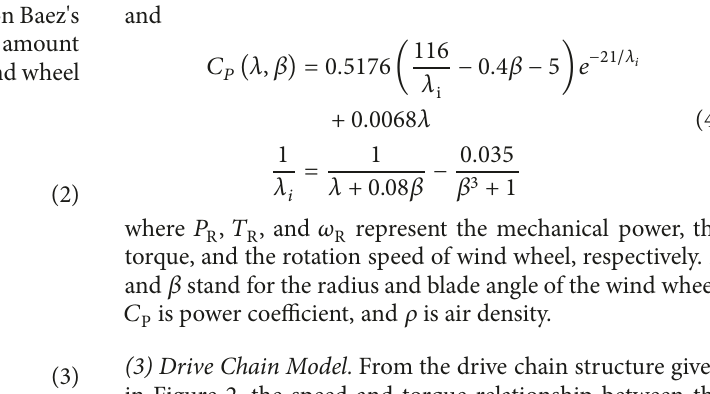
(2) Aerodynamics Model of the Wind Turbine. Based on